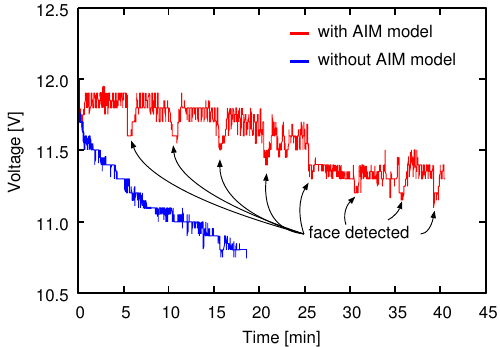
Figure 11. Variations of battery voltage with